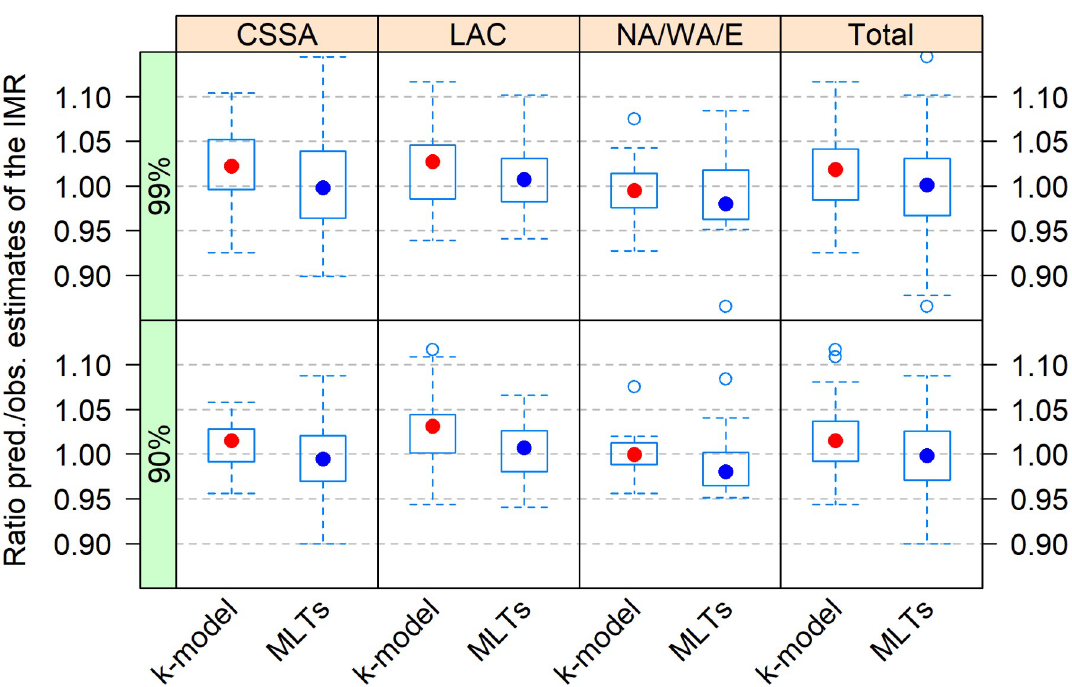
Fig 4. Predicted vs observed ratio of the IMR in individual DHS surveys by world region with predictions made using the k-model or MLTs. CSSA is for Central, South, and Southeast Asia. LAC is for Latin America & Caribbean. NA/WA/E is for North Africa/West Asia/Europe. Sub-Saharan Africa results are not showed because they include only one